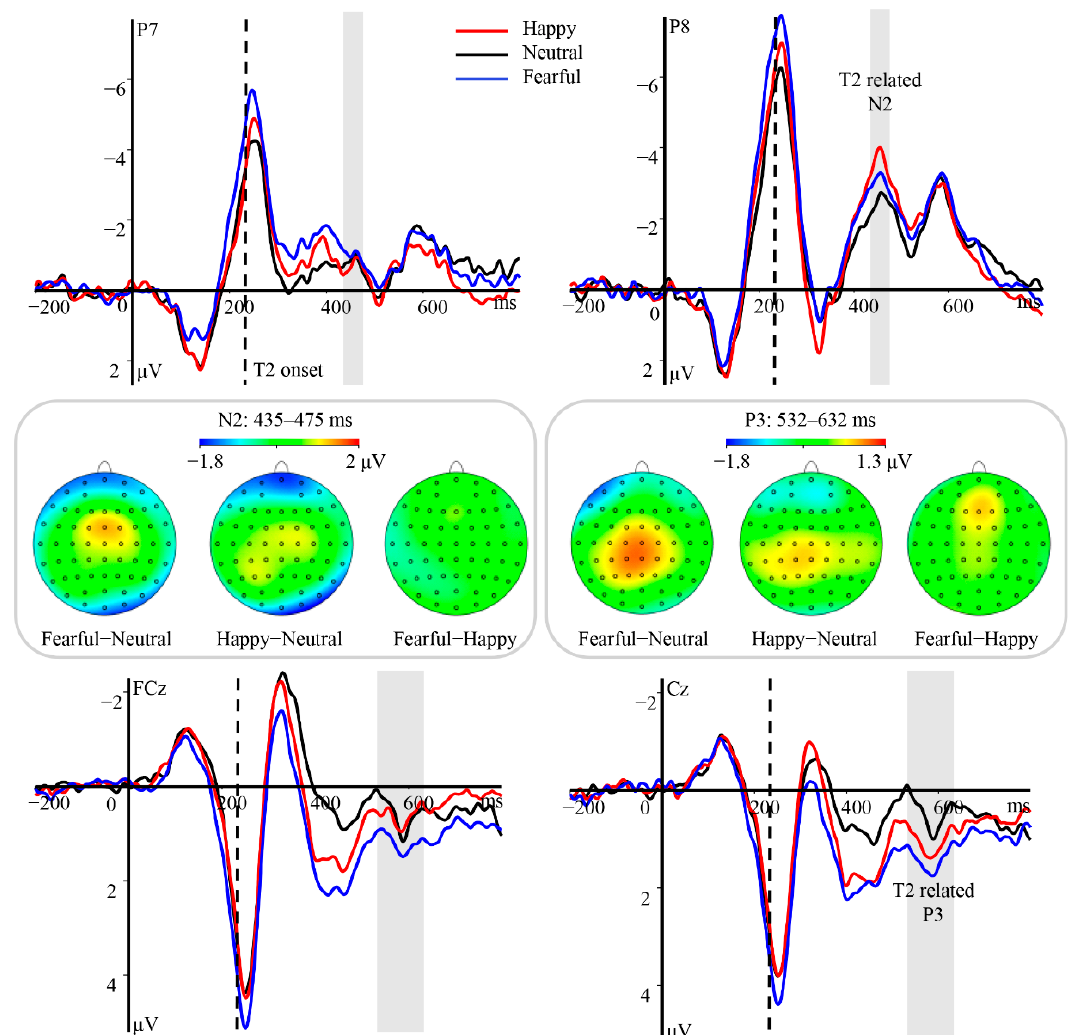
Figure 3. Main effects of T1 valence on T2-related N2 and P3 components. Top and bottom panels: Grand average ERP waveforms for N2 and P3 for T2 houses in the happy (red line), neutral (black line), and fearful (blue line) conditions at the indicated electrodes. Gray areas indicate the time windows of N2 and P3. Middle panel: Topographical difference maps depicting the emotional valence effect for T2 houses within the AB period during the time windows for N2 and P3.